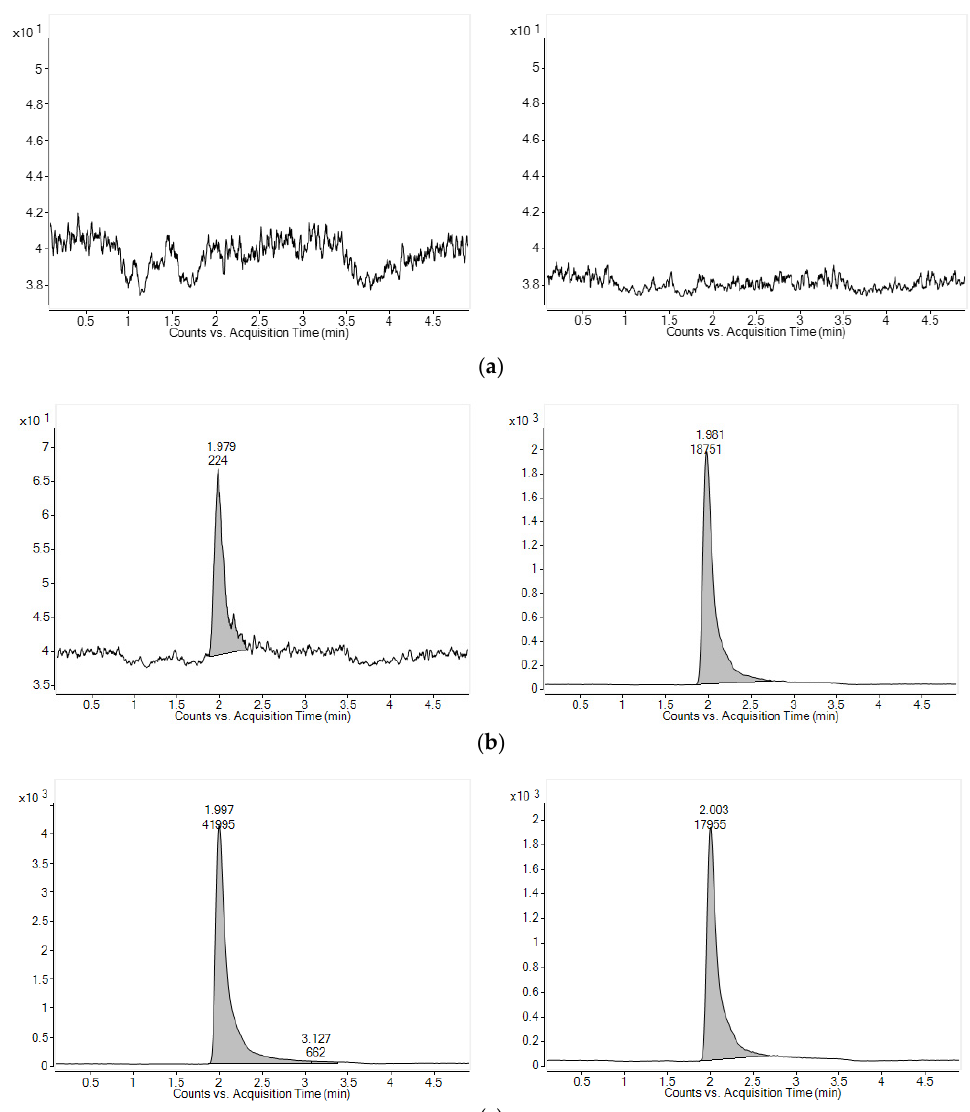
Figure 2. MRM chromatograms of hexamethylenetetramine ( left ) and internal standard ( right ) obtained from ( a ) blank rat plasma, ( b ) LLOQ concentration (5 ng/mL) of hexamethylenetetramine in plasma spiked with hexamethylenetetramine and I.S., and ( c ) ULOQ concentration (1000 ng/mL) of hexamethylenetetramine in plasma spiked with hexamethylenetetramine and I.S. Table 2. Intra- and inter-day accuracy and precision of LLOQ (5 ng/mL) and QC samples (15–800 ng/mL) for hexamethylenetetramine in rat